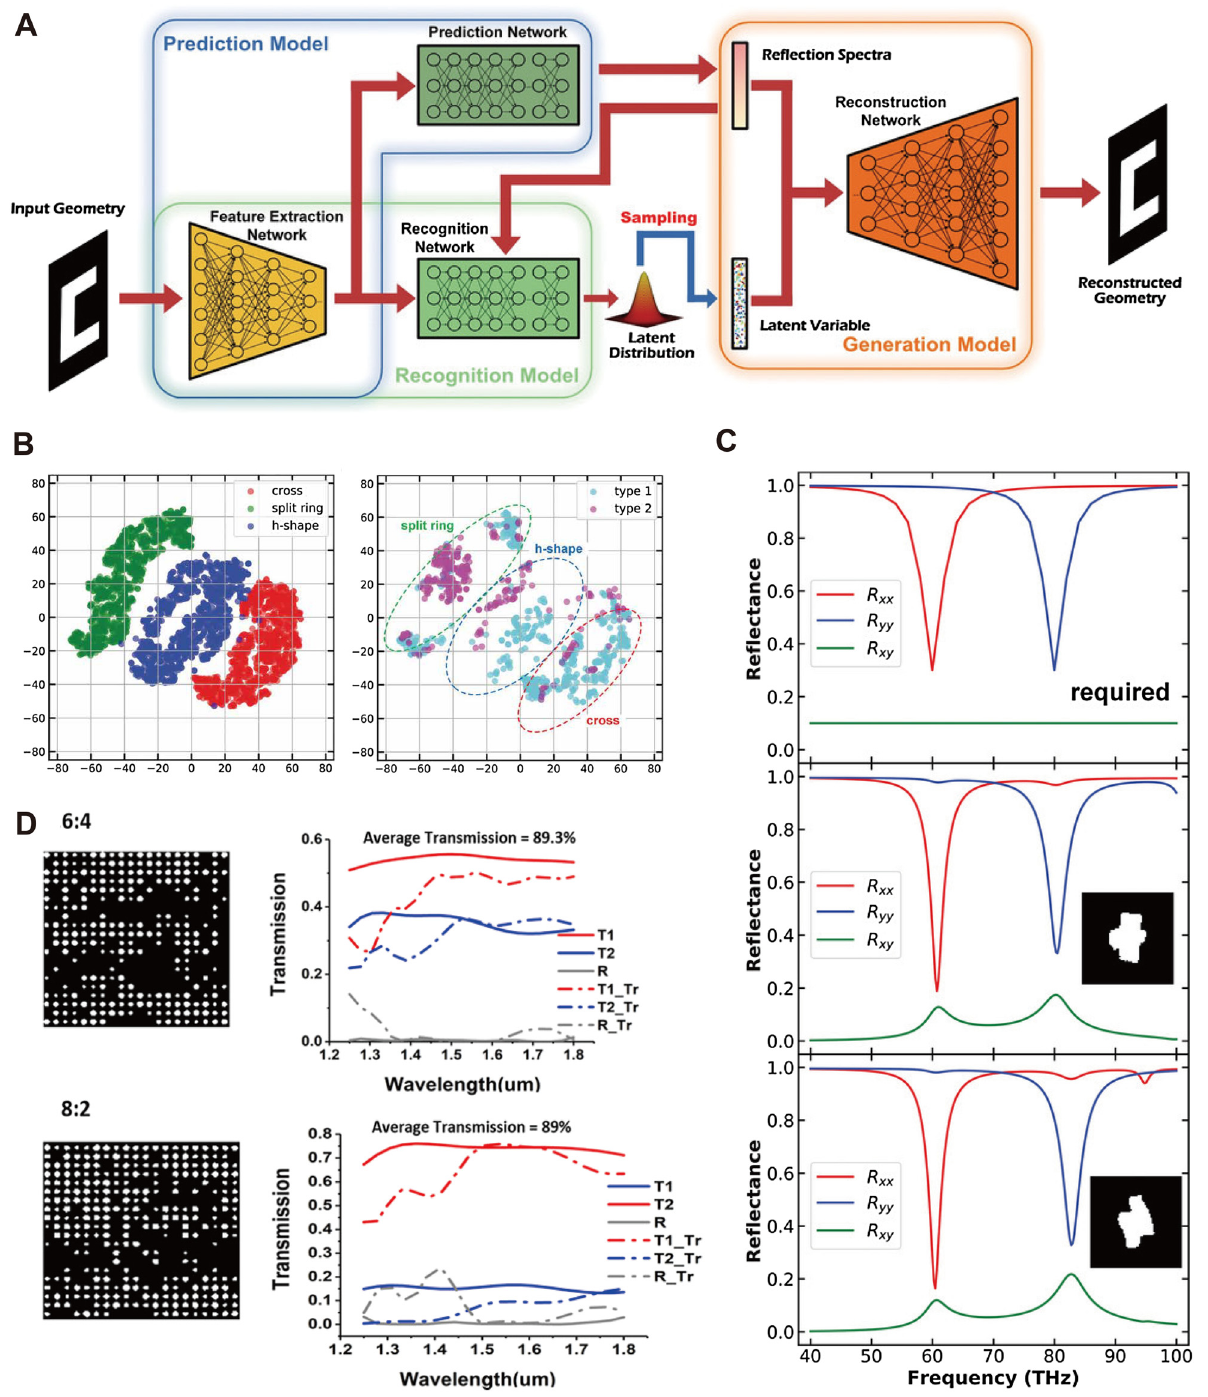
Figure 6: Variational autoencoder (VAE) assisted nanopotonic design (A) a c-VAE based metamaterial design system, including a prediction model, recognition model, and generation model. (B) Visualization of the reduced latent space, where three types of geometries and two-types of optical responses are depicted on the plot. (C) Examples of on-demand metamaterial reflector design. Two equivalent structures are generated under the given spectra condition. (A), (B) and (C) are adapted from [113]. (D) Examples of broadband power splitters with 2.25